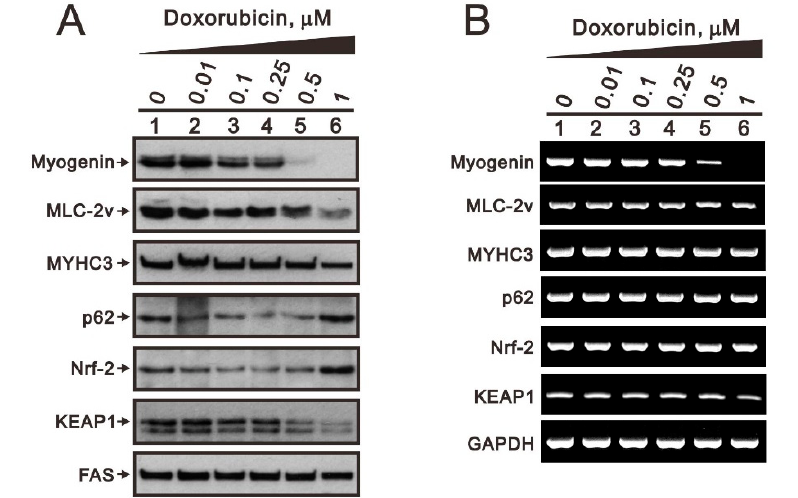
Figure 4. The effects of doxorubicin on the Keap1/Nrf2/p21/myogenin pathway in differentiated C2C12 cells. After induction of differentiation by culturing C2C12 cells in differentiation medium for 3 days, differentiated C2C12 cells were treated with the indicated concentration of doxorubicin for 20 h. ( A ) Cell lysates were subject to immunoblot analysis against myogenin, MLC-2v, MYHC3, p62, Nrf2, and Keap1 proteins. FAS was used as loading control. ( B ) Effects of doxorubicin on the mRNA expression of myogenin , MLC-2v , MYHC3 , p62 , Nrf2 , and Keap1 determined by RT-PCR. GAPDH was used as loading control.